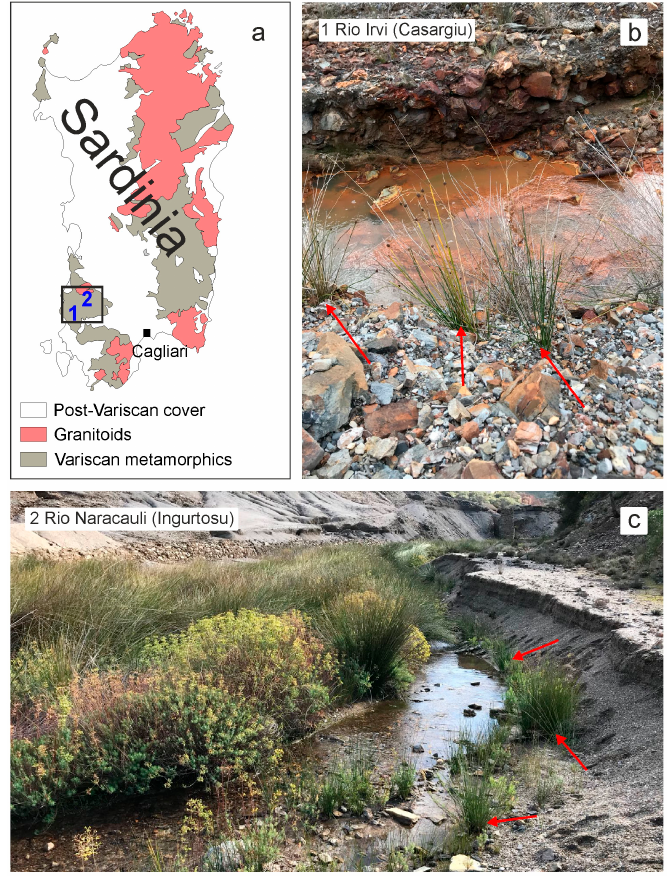
Figure 1. Schematic geological map of Sardinia ( a ). Sampling sites along Rio Irvi ( b ) and Rio Naracauli ( c ). Red arrows indicate the harvested